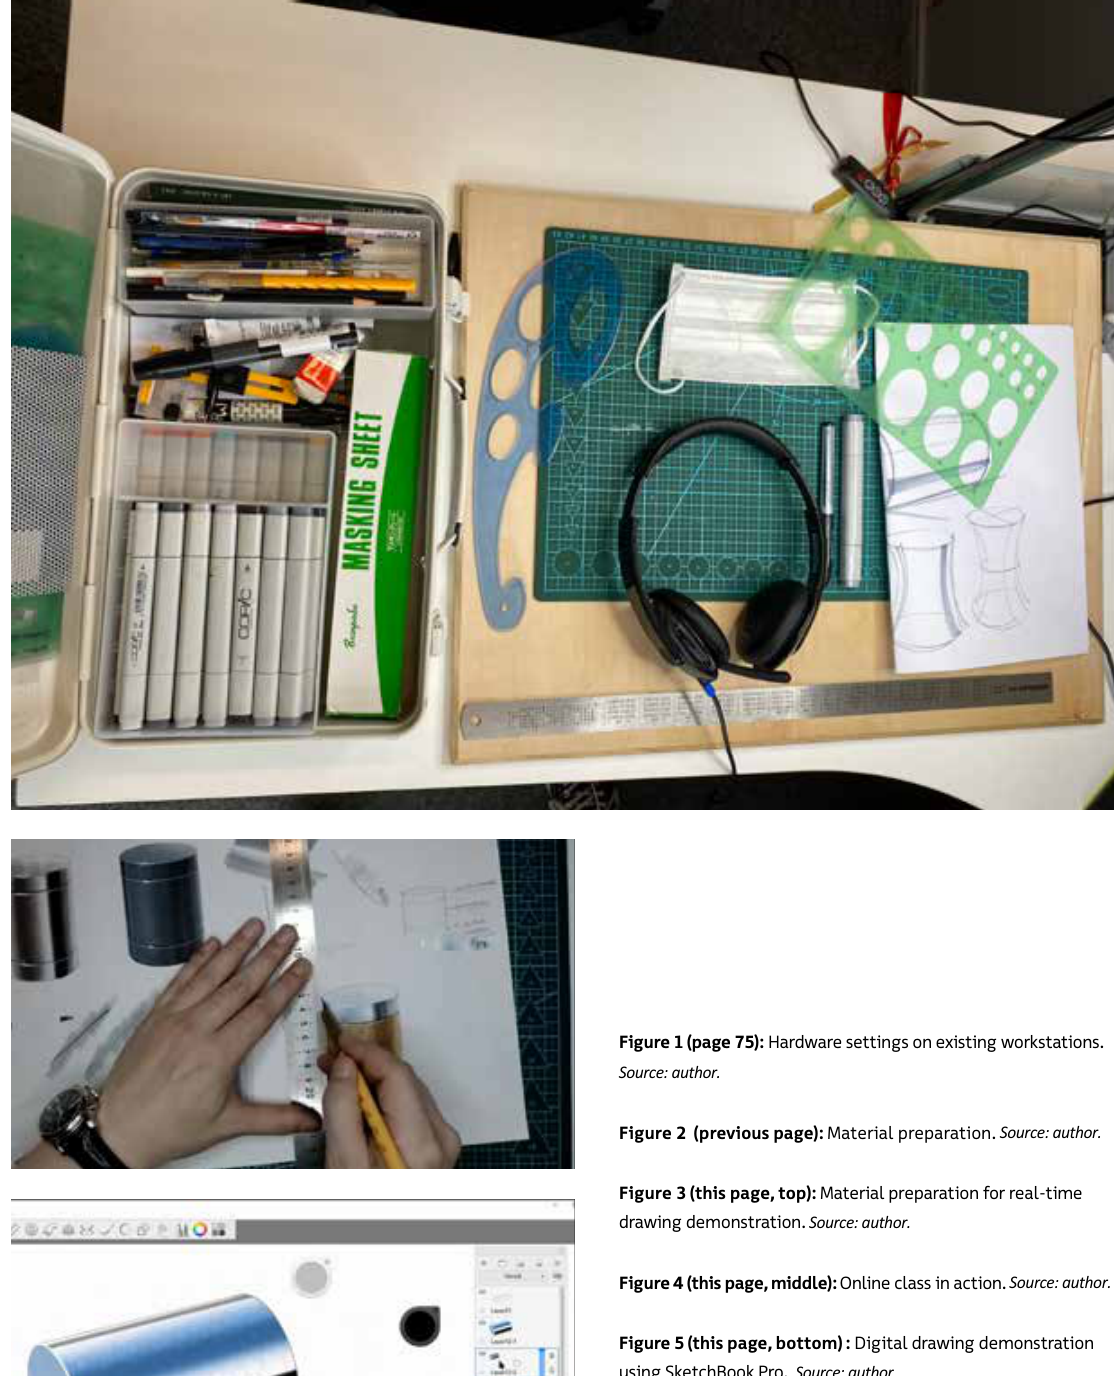
Figure 1 (page 75): Hardware settings on existing workstations. Source: author. Figure 2 (previous page): Material preparation. Source: author. Figure 3 (this page, top): Material preparation for real-time drawing demonstration. Source: author. Figure 4 (this page, middle): Online class in action. Source: author. Figure 5 (this page, bottom) : Digital drawing demonstration using SketchBook Pro. Source: author. Figure 6 (page 78, top): Screenshot of manual drawing demonstration. Source: author. Figure 7 (page 78, bottom): Impact of online education. Demonstration of tutoring set-up. Source: